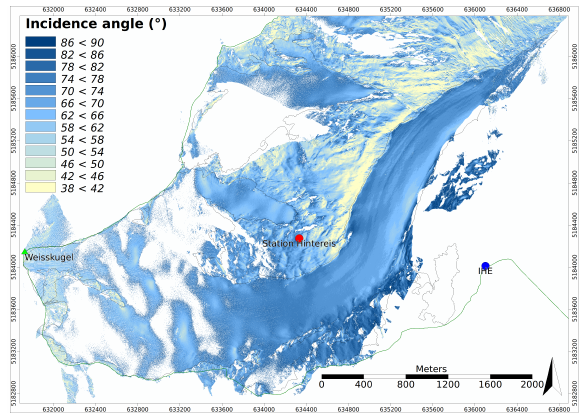
Figure 6. The incidence angles of the laser beam from the position of IHE in ◦ from the zenith as calculated with the scan of 6 November 2020 14:06.